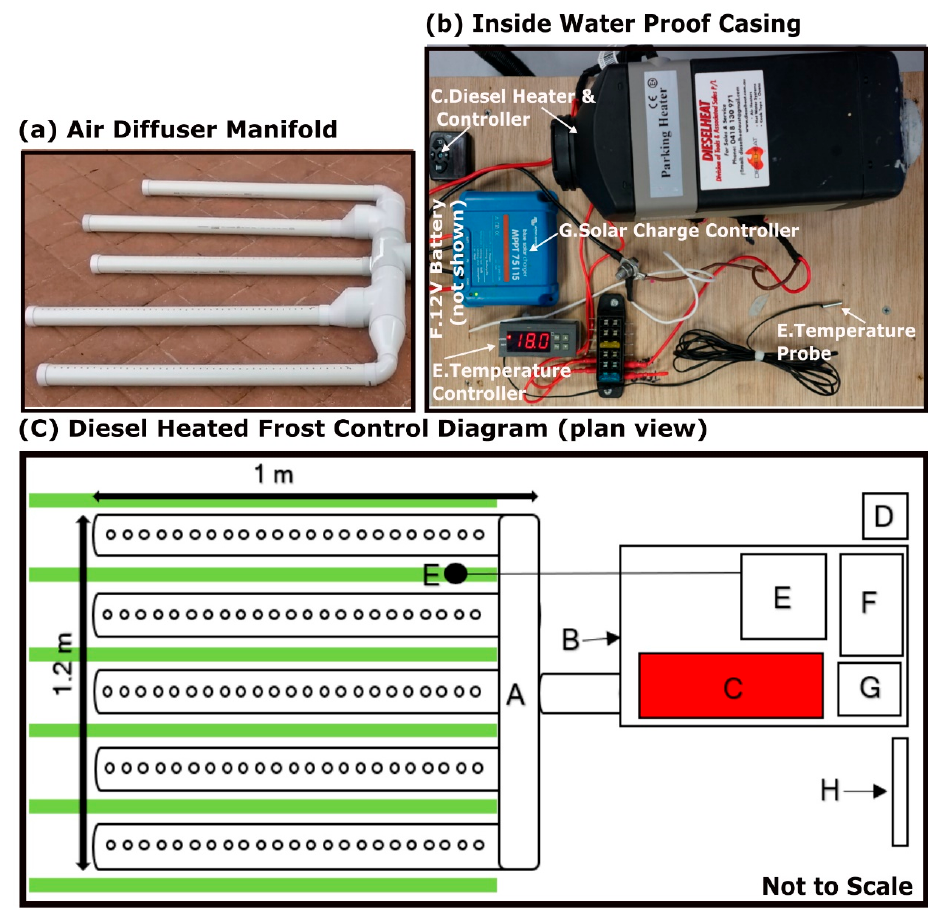
Figure 1. ( a ) Image of the air diffuser manifold (PVC pipes). ( b ) Image of heater set up inside of the